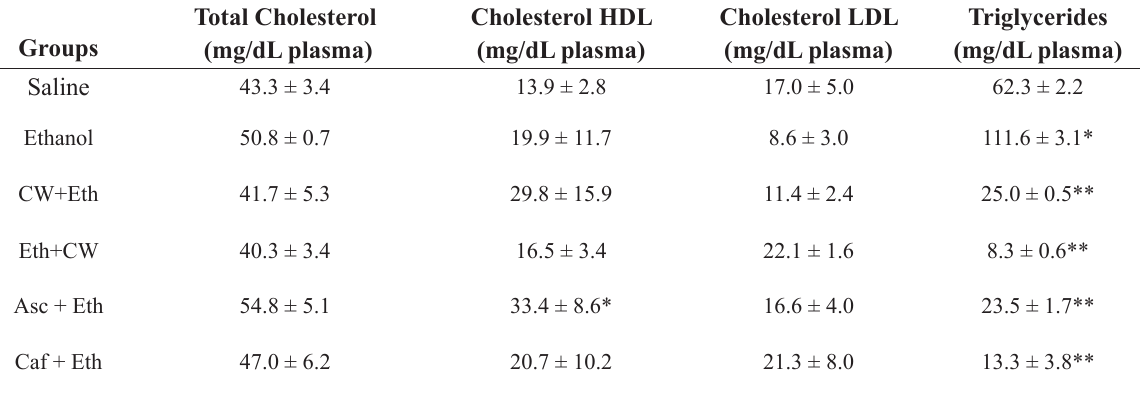
Effect of coconut water, ascorbic and caffeic acids in the lipid profile of rats treated by ethanol.